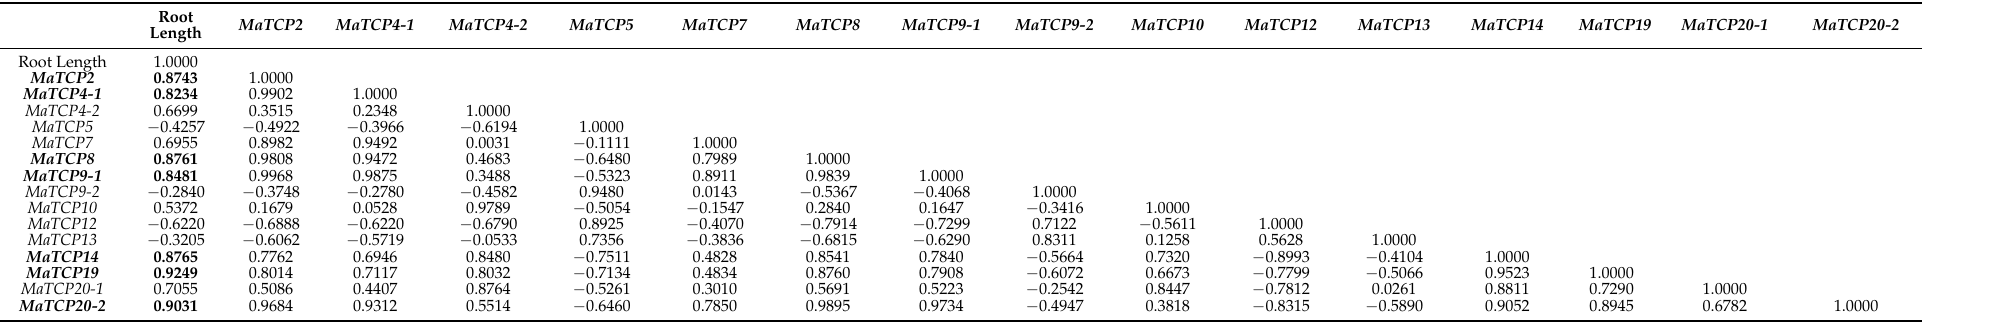
Table 2. Correlation coefficients between the relative expression of MaTCP genes and root